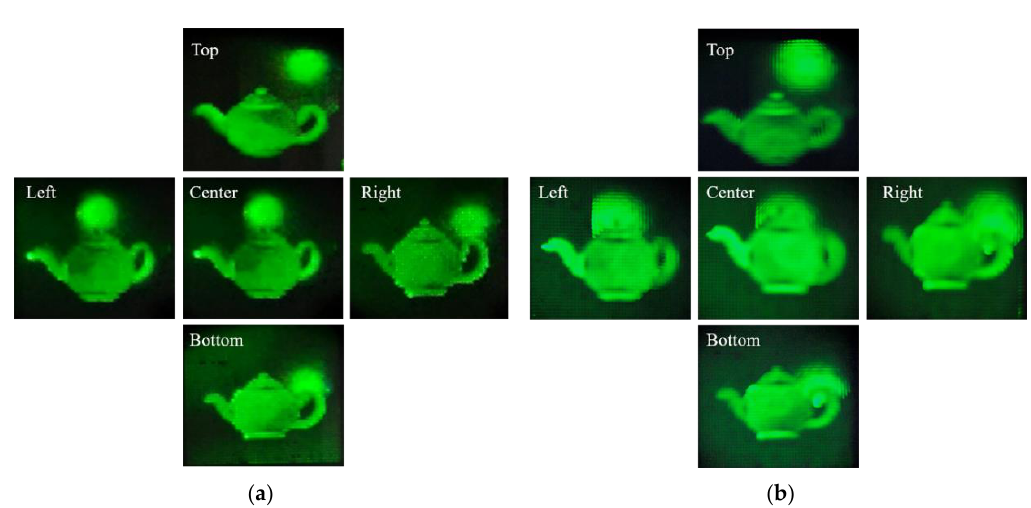
Figure 11. Optical reconstruction of full-parallax holographic stereogram for object “Teapot and sphere” ( a ) conventional method and ( b ) proposed method.